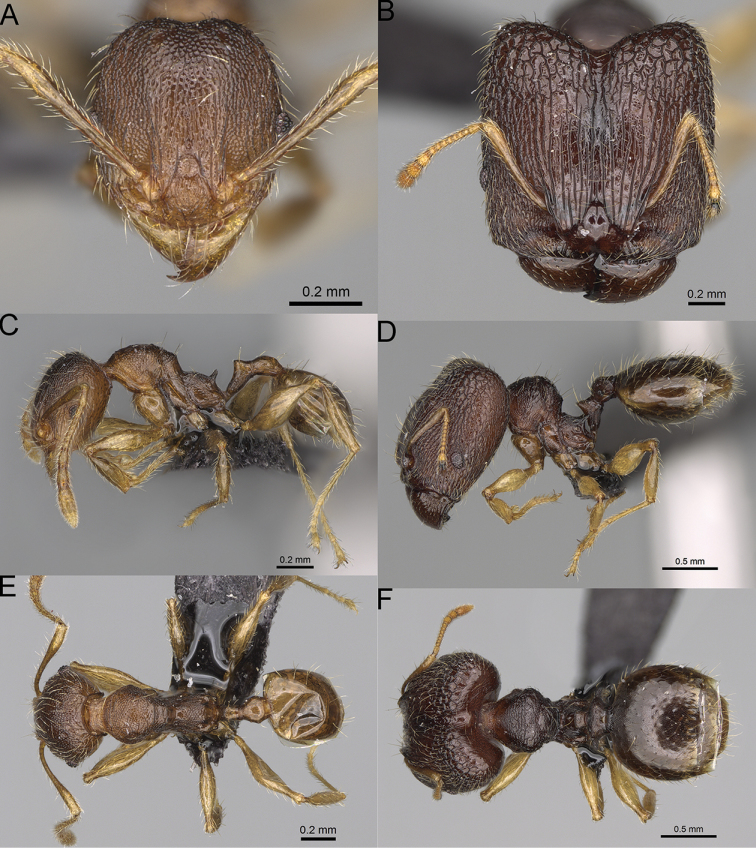
Pheidole
glabra sp. nov., full-face view (A), profile (C), and dorsal view (E) of paratype minor worker (CASENT0235034) and full-face view (B), profile (D), and dorsal view (F) of holotype major worker (CASENT0134271).